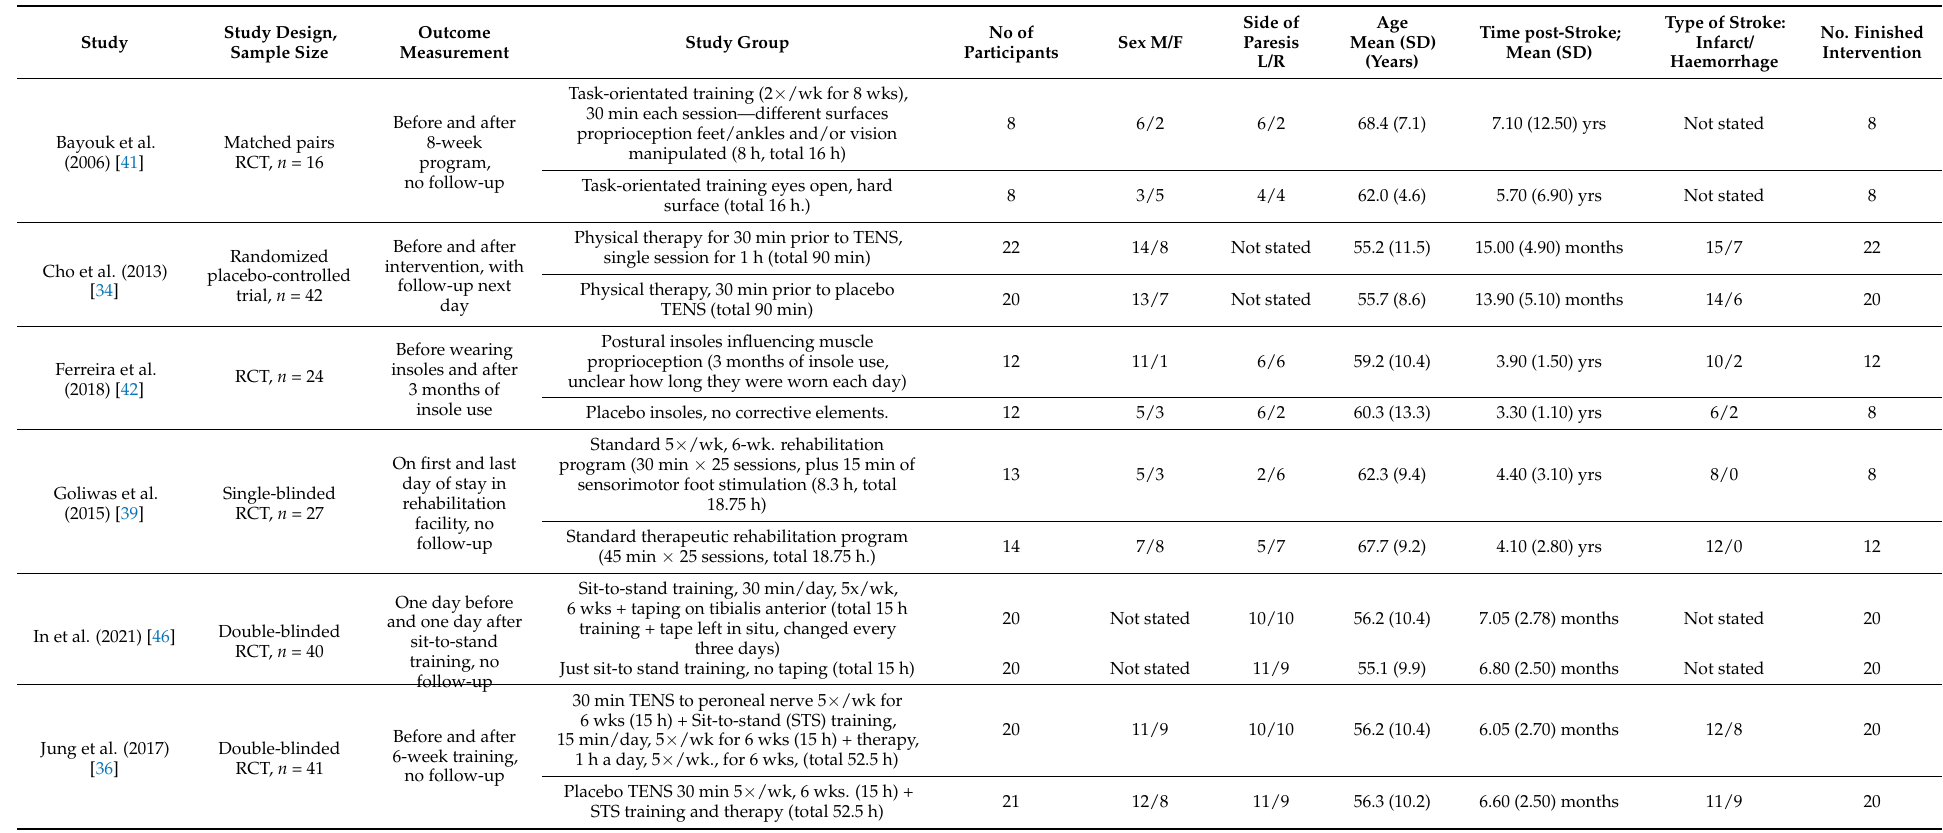
Table 3. Details of participants and group allocations in included